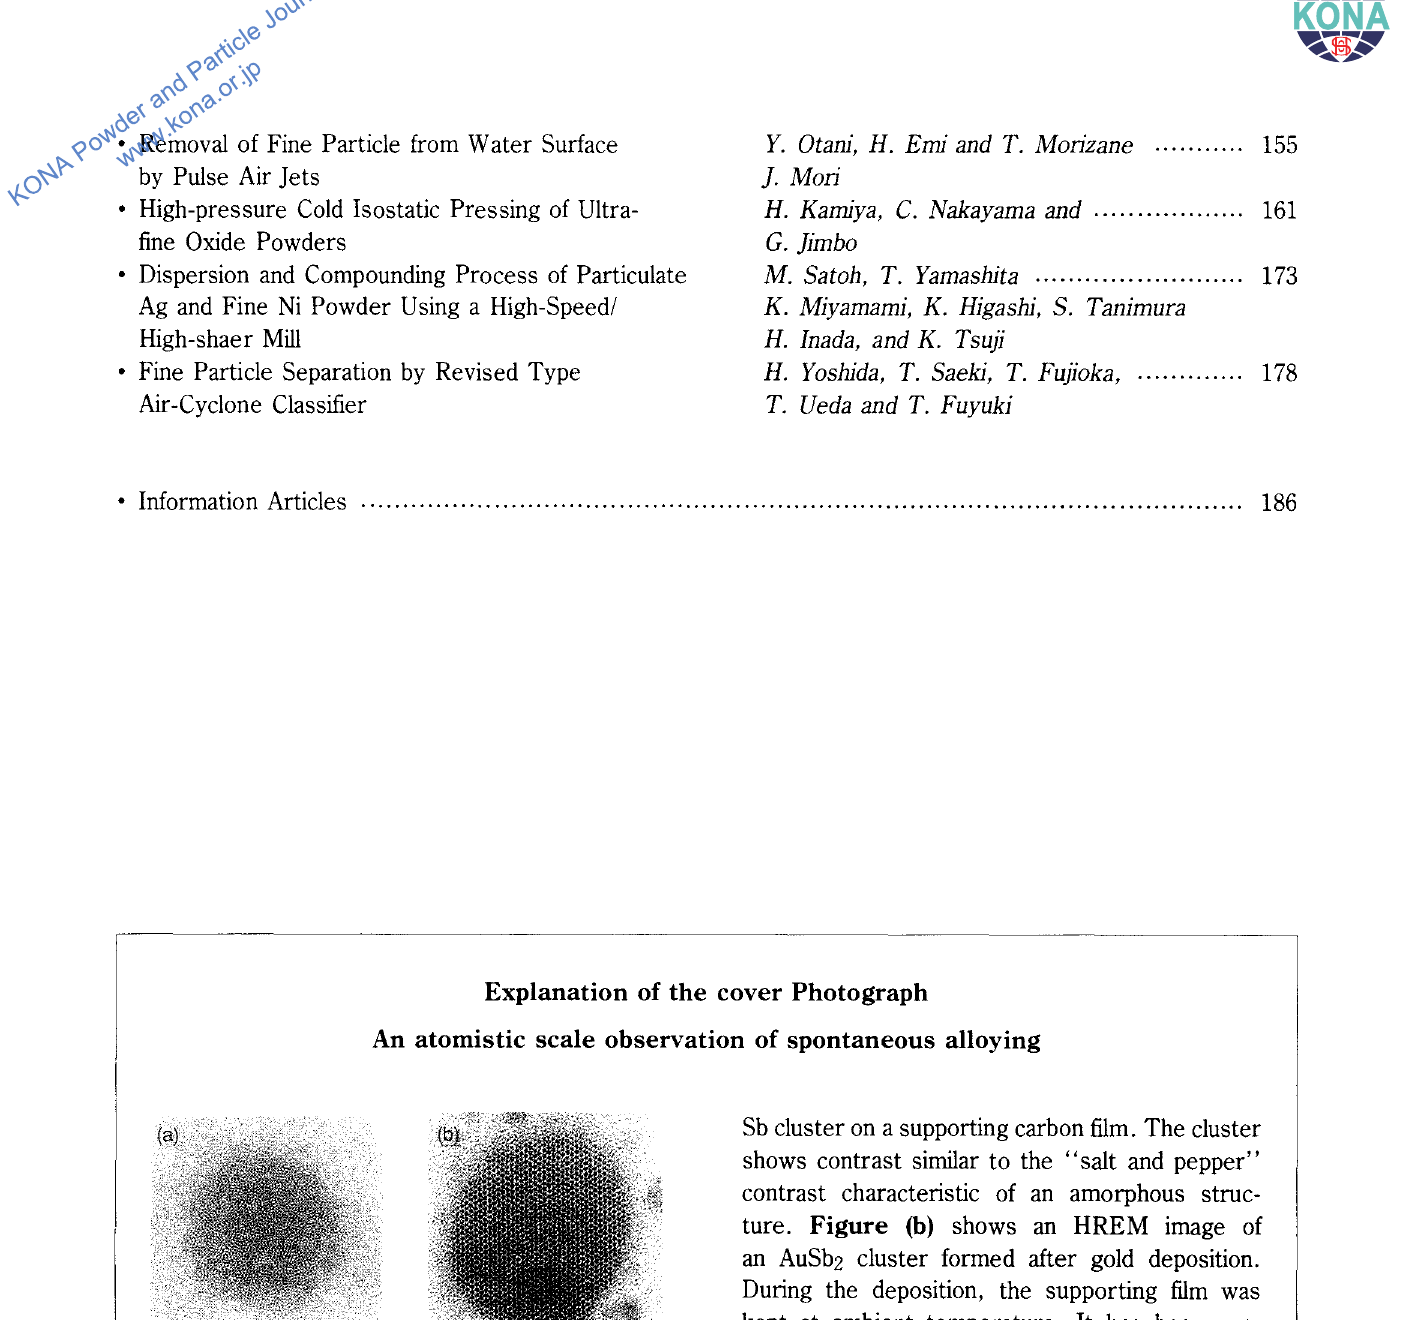
Sb cluster on a supporting carbon film. The cluster shows contrast similar to the "salt and pepper" contrast characteristic of an amorphous struc ture. Figure (b) shows an HREM image of an AuSbz cluster formed after gold deposition. During the deposition, the supporting film was kept at ambient temperature. It has been con firmed by an optical diffraction experiment of the cluster image that the incident beam direction is [111] of the AuSb cluster. Small clusters of 2 approximately 4 nm in the mean diameter, dis persed on the supporting carbon film, are gold. Through the HREM experiment, it becomes evident that when gold is evaporated onto amor phous Sb clusters, gold atoms which come in contact with Sb clusters quickly dissolve into the clusters and Ausb compound clusters are formed 2 even at ambient temperature. It is also known that the ease with which such rapid spontaneous alloying takes place decreases with increasing size of original amorphous Sb